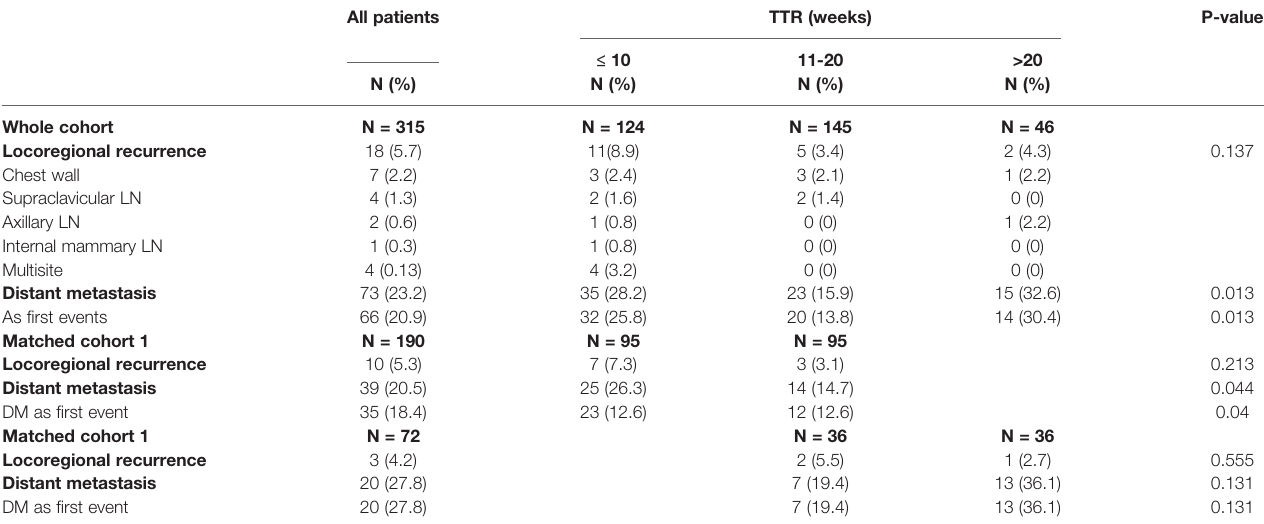
TABLE 2 | Pattern of failures by TTR among patients treated with NATs.